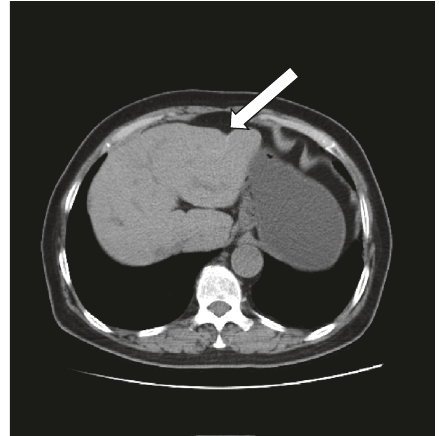
Figure4:CTscanshowingalinearcalcificationconsistentwithliver fibrosis due to S. japonicum .